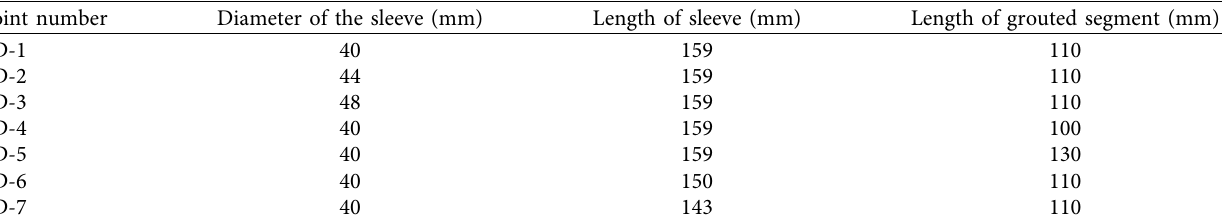
Table 9: Model parameters of parametric studies.